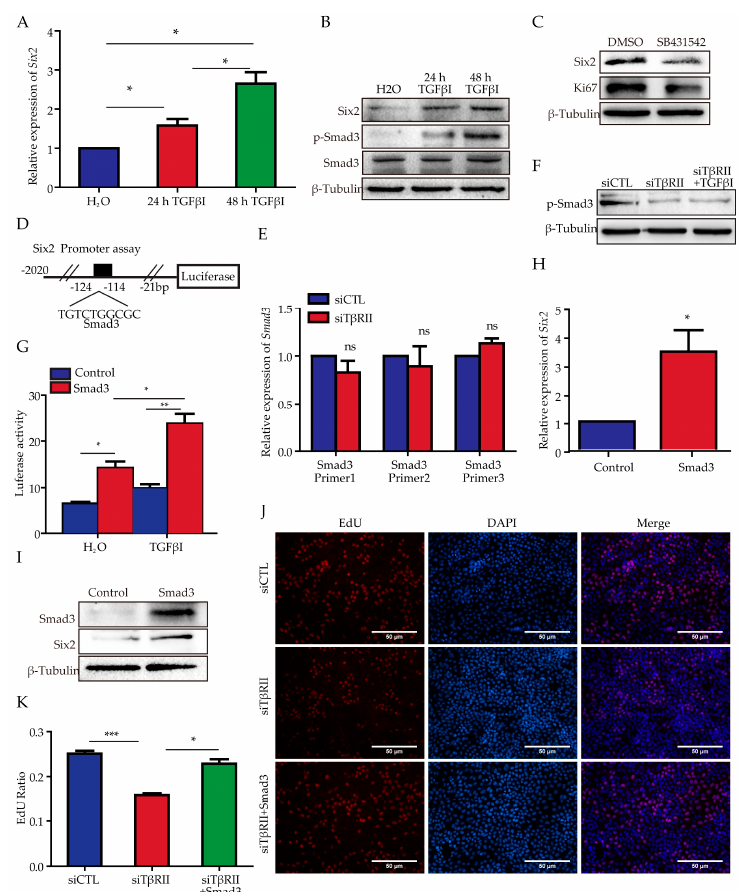
Figure 4. Smad3 transcriptionally regulates Six2 and rescues the proliferation phenotype. ( A ) The mRNA level of Six2 under the time course stimulation of TGF β I (2 ng/mL); ( B ) The protein levels of Six2 and p-Smad3 under the time course stimulation of TGF β I (2 ng/mL); ( C ) The protein level of Six2 and Ki67 after the treatment of phosphorylation Smad3 ( p-Smad3) inhibitor SB431542 (10 µM) for 48 h; ( D ) The promoter analysis of Six2 via an online prediction tool (website: http://alggen.lsi.upc.es/cgi-bin/promo_v3/promo/promoinit.cgi?dirDB=TF_8.3); ( E ) The detection of the mRNA level of Smad3 via three pairs of primer in mK3 cells after the treatment of siT β RII; ( F ) The protein level of p-Smad3 with or without the stimulation of TGF β I (2 ng/mL) for 48 h after the knock down of T β RII ; ( G ) pRL-SV40 and Six2 promoter luciferase reporter together with the control vector or Smad3 under the stimulation of Tgf β I (2 ng/mL) for 48 h were transfected into HEK293 cells. After 48 h, the cells were lysed and the fluorescences were detected and normalized to Renilla activity; ( H ) The mRNA level of Six2 after the overexpression of Smad3 in mK3 cells; ( I ) The protein level of Six2 after the overexpression of Smad3 in mK3 cells; ( J ) The proliferation rate of mK3 cells after the transfection of siT β RII and the co-transfection of Smad3; ( K ) Histogram shows the quantitative analysis of the EdU assay above; ( K ) The proliferation rate of mK3 cells after the transfection of siT β RII and the co-transfection of Smad3. All data are displayed as means ± SD from three independent experiments. * p < 0.05, ** p < 0.01, *** p < 0.001.